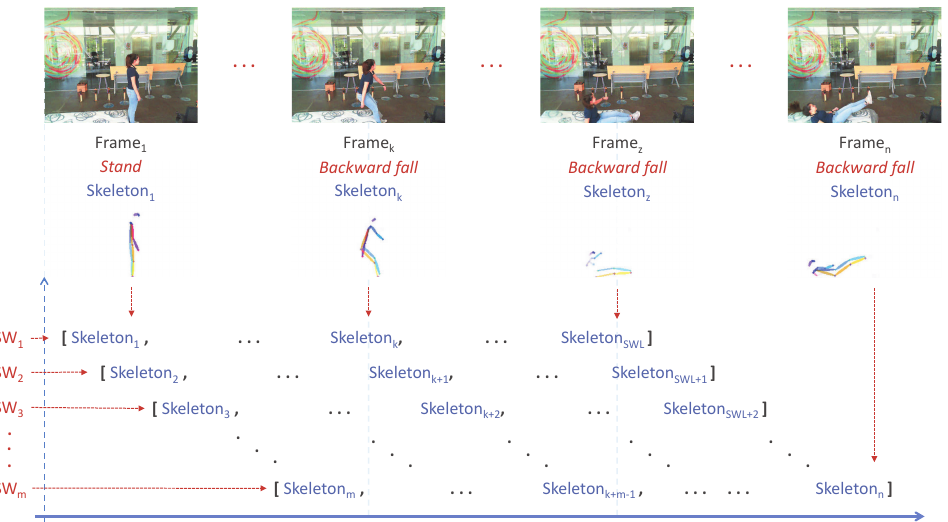
Figure 2. Sliding Windows for activity